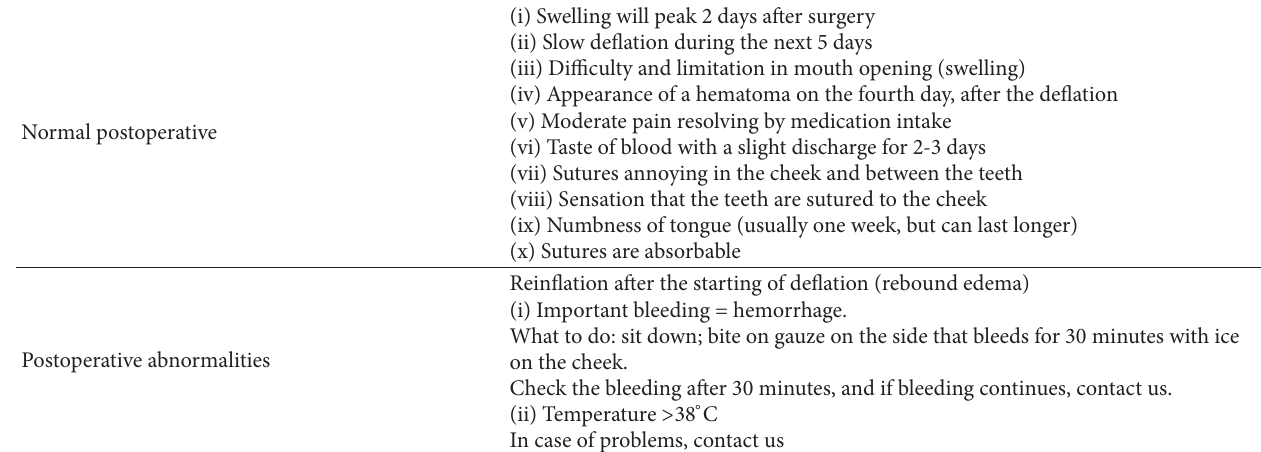
Table 4: Post operative abnormalities information given to patient after